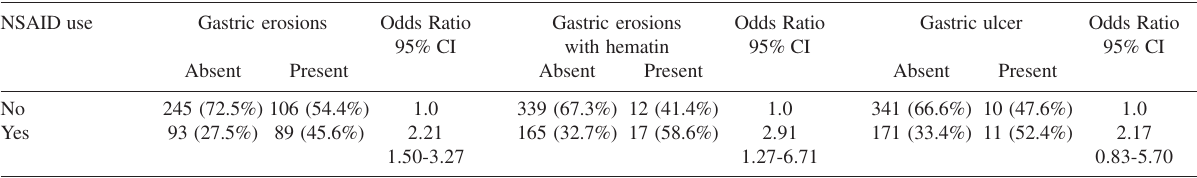
Table 1 - Association between nonsteroidal anti-inflammatory drugs (NSAID)use and the occurrence of gastric lesions according to univariate